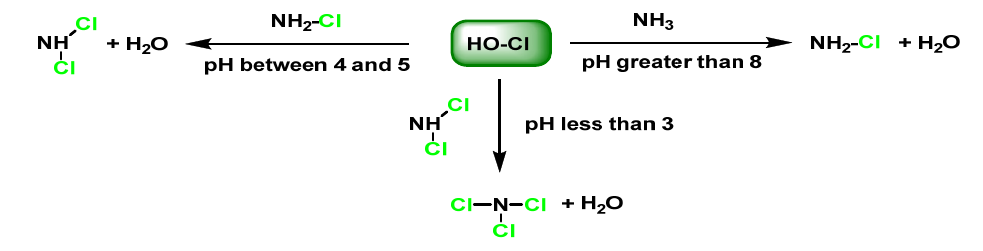
Figure 18. Synthesis of mono, di, and trichloro ammonia.